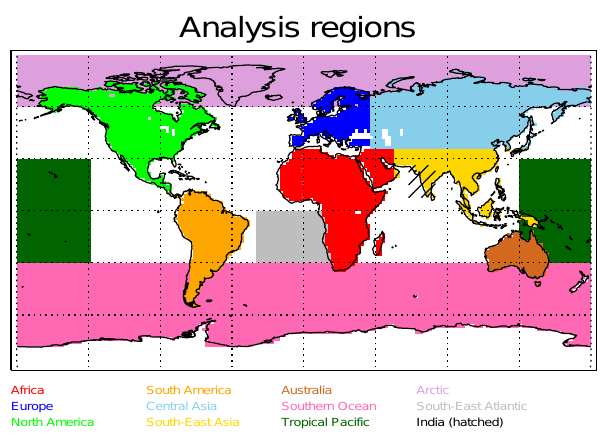
Figure 3. Map of regions used in the